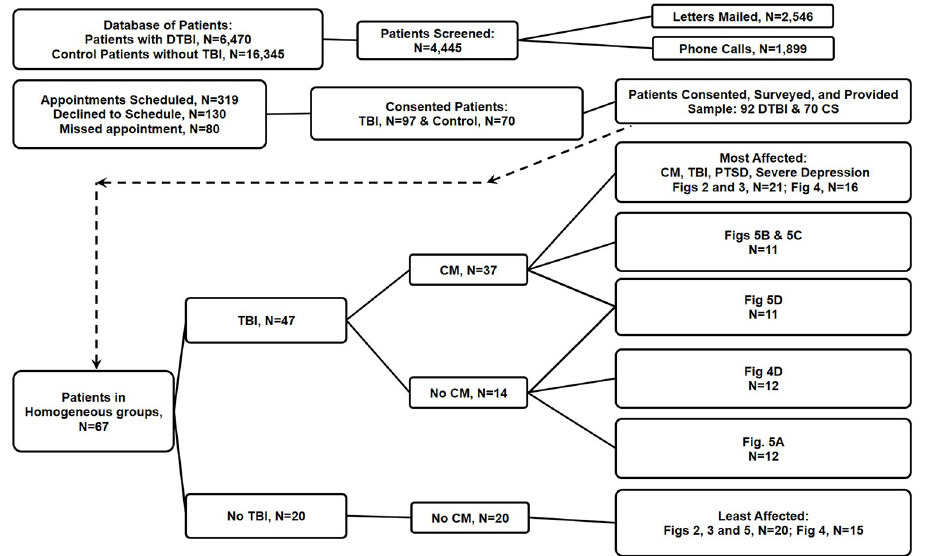
Fig 1. Study volunteer numbers, health characteristics, groupings, and figure inclusions. The number of patients available for recruitment, number of patients recruited, number of patients utilized, and the identification of the figures where these patients were utilized, are indicated.